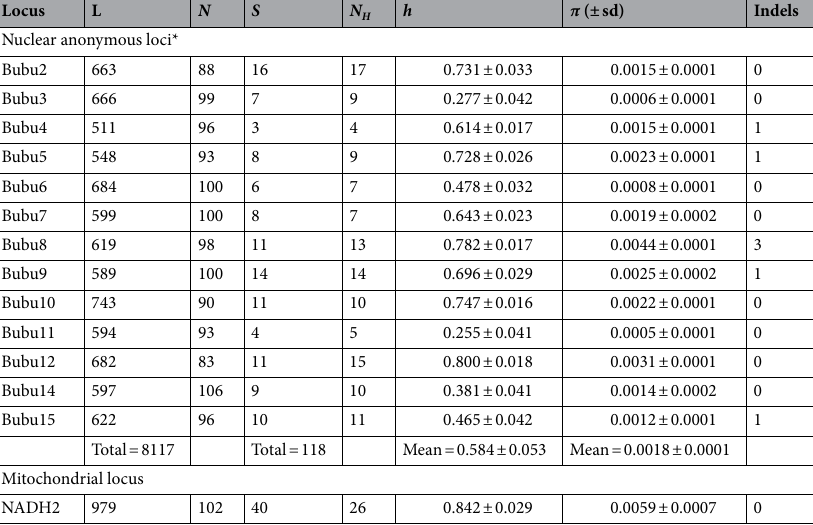
Table 1. Polymorphic statistics for all the loci sampled in this study. L–length of the locus in bp; N–number of samples; S–number of segregating sites; N H –number of haplotypes; h –haplotype diversity; π –nucleotide diversity. *Anonymous loci described in Silva et al. 30